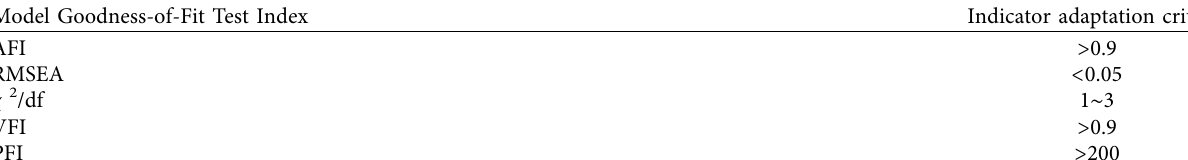
Table 6: Model Suitability Index and suitability